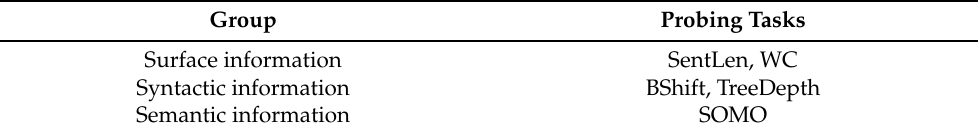
Table 2. Grouping of probing tasks.